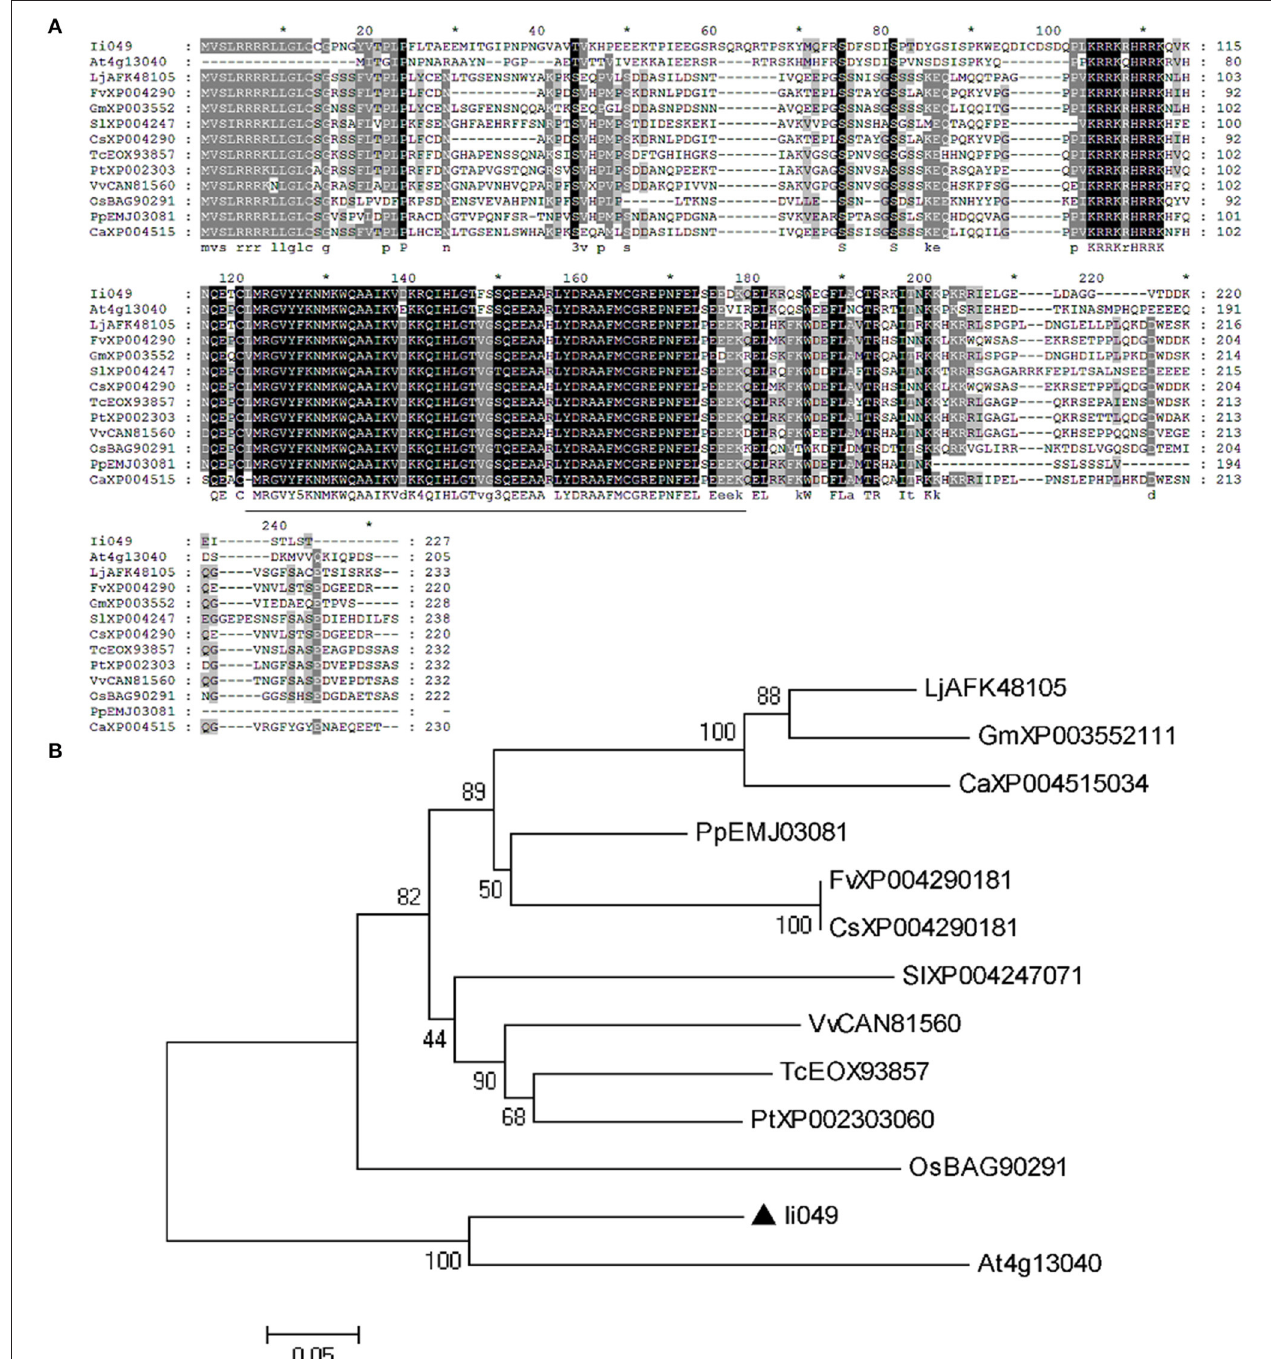
FIGURE 2 | Sequence comparison between Ii049 and related AP2/ERF family protein. (A) Amino acid alignment of Ii049 with several Soloist-like proteins in different plant species, the AP2 domain has been underlined. (B) Phylogenetic tree of Ii049 and other plant Soloist-like proteins using MEGA 5.0 software based on the neighbor-joining method. Gene names with their accession numbers are listed in Supplementary Table S2